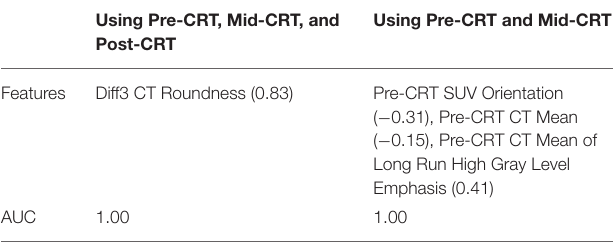
TABLE 4 | Selected anal cancer recurrence predictors (correlation to the recurrence in parentheses) by naïve Bayesian classifier. Using Pre-CRT, Mid-CRT, and Post-CRT